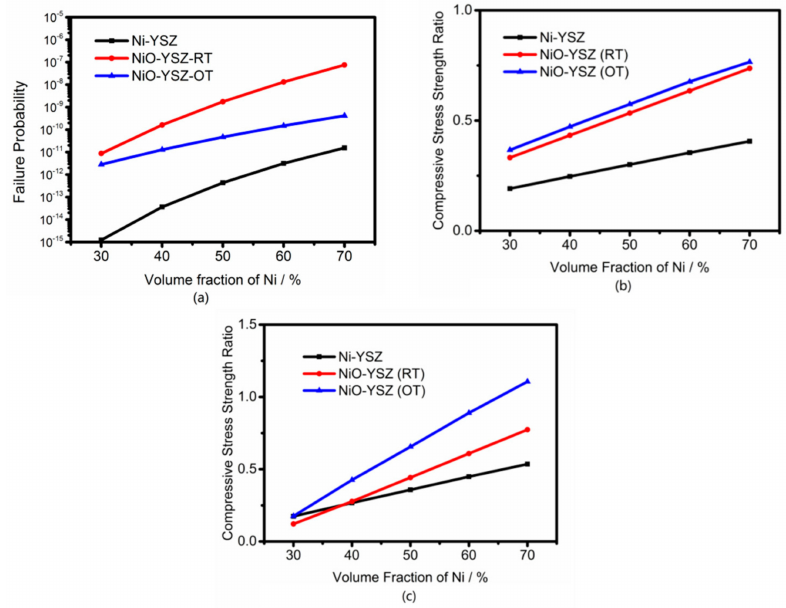
Figure 3. Effects of volume fraction of Ni in Ni-YSZ anode at OT (black line), NiO-YSZ anode at RT (red line), and OT (blue line) on ( a ) the failure probability of anode; ( b ) the compressive stress strength ratio of electrolyte; ( c ) the compressive stress strength ratio of cathode.